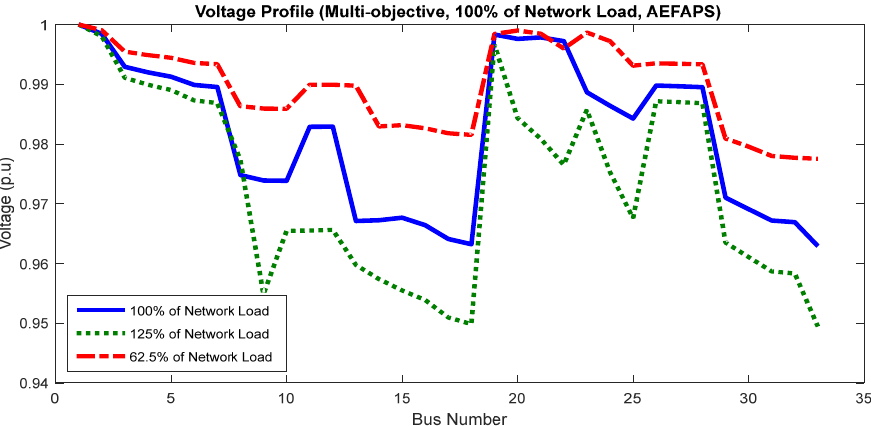
Figure 15. Percentage of improvement of objective function indices by AEFAPS for an unbalanced 33-bus network.